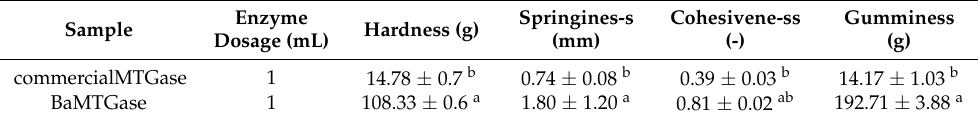
Table 1. Texture of MTGase-induced SPI